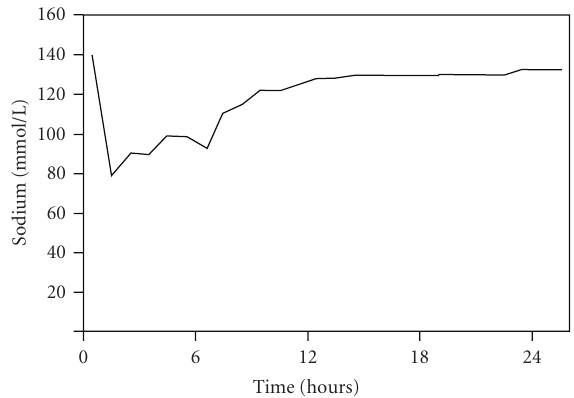
Figure 1: Postoperative correction of plasma sodium levels.